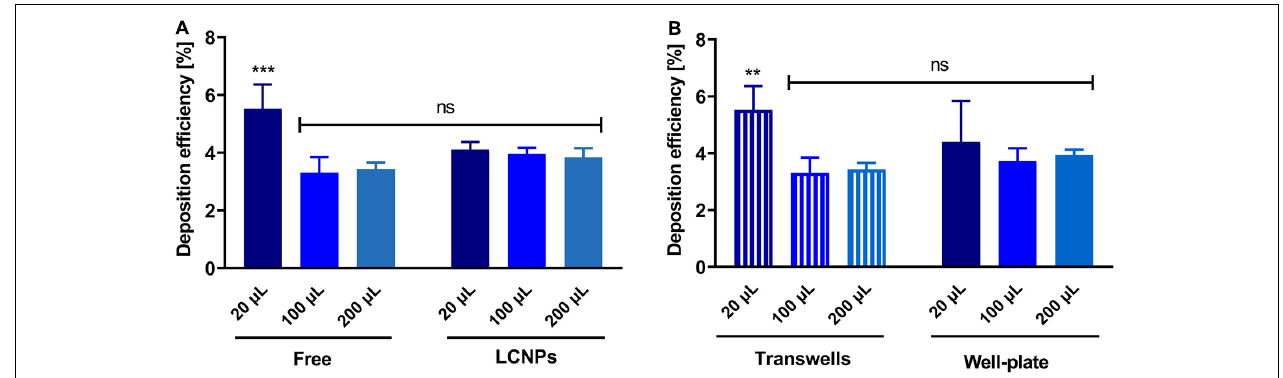
FIGURE 4 | Comparison of deposition efficiency of different volumes, substances, and wells. (A) Deposition efficiencies of free sodium fluorescein and LCNPs loaded with sodium fluorescein. Substance deposited on the apical side of permeable supports was analyzed (the section “Materials and Methods”), N = 9 of two experiments (for 20 µ l of free and LCNP, 100 and 200 µ l of LCNP); N = 6 of two experiments (for 100 µ l of free); N = 8 of three experiments (for 200 µ l of free). (B) Comparison of deposition efficiency on 24-well plates and Transwell R (cid:13) inserts. Sodium fluorescein was nebulized using the device as described. Either the device deposited on Transwell R (cid:13) inserts or 24-well plate inserts. Data show mean and standard deviation. N = 9 of three experiments; 100 µ l, N = 6 of two experiments. Two-way ANOVA, Sidak’s multiple comparisons test; *** p < 0.001; ** p < 0.003; ns, no significant difference ( p > 0.05).